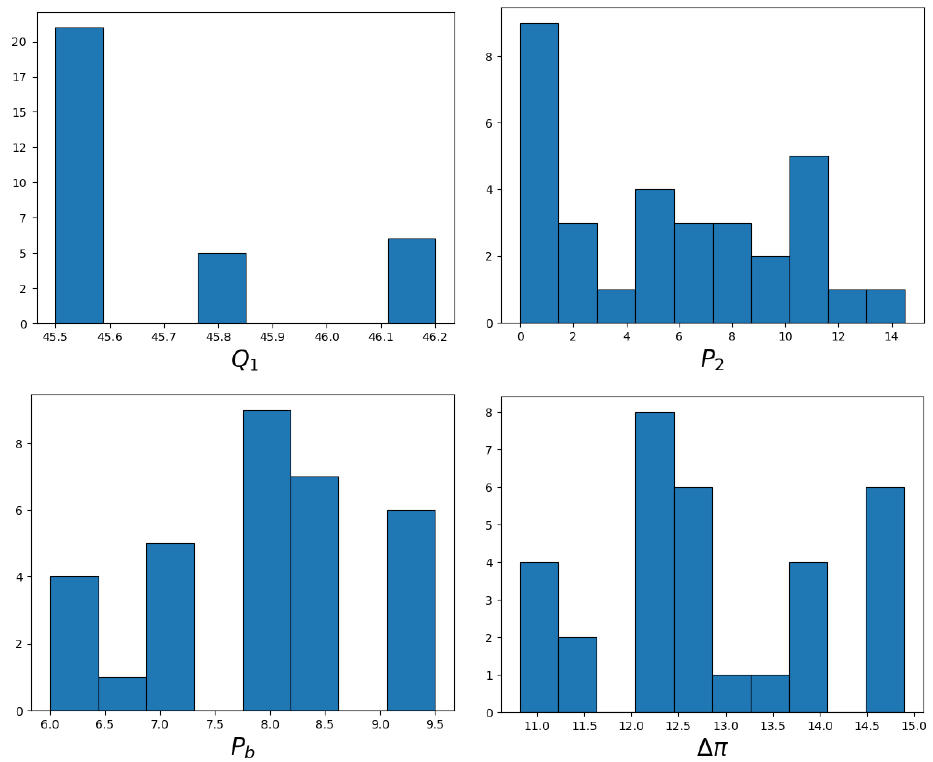
Figure 2. Histograms of experimental data on lymph flow and absorption in the LN. Q 1 is the afferent lymphatic flow rate, P 2 is the efferent lymphatic pressure, p b is the characteristic LN blood vessel pressure and ∆ π is the average difference between LN blood vessels pressure and LN interstitium oncotic pressure (data from Table 1 of paper [35]). The vertical axes count how many values fall into each bin interval (i.e., the number of experiments with the measurement results belonging to the respective